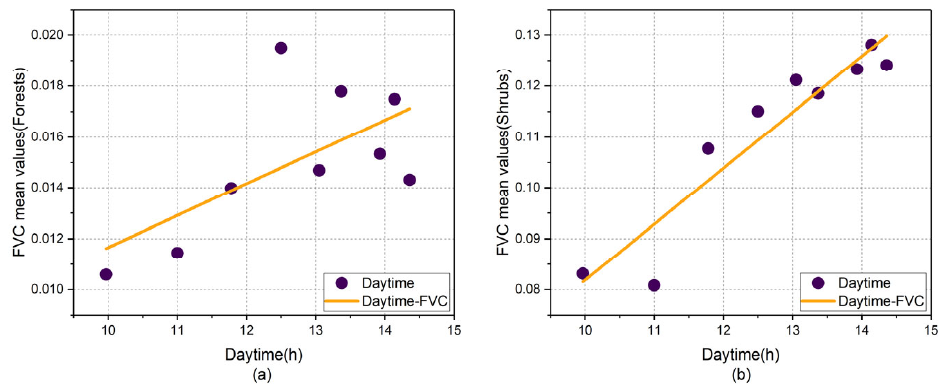
Figure 10. Daytime and vegetation regeneration relationship map: ( a ) forests-daytime and ( b )